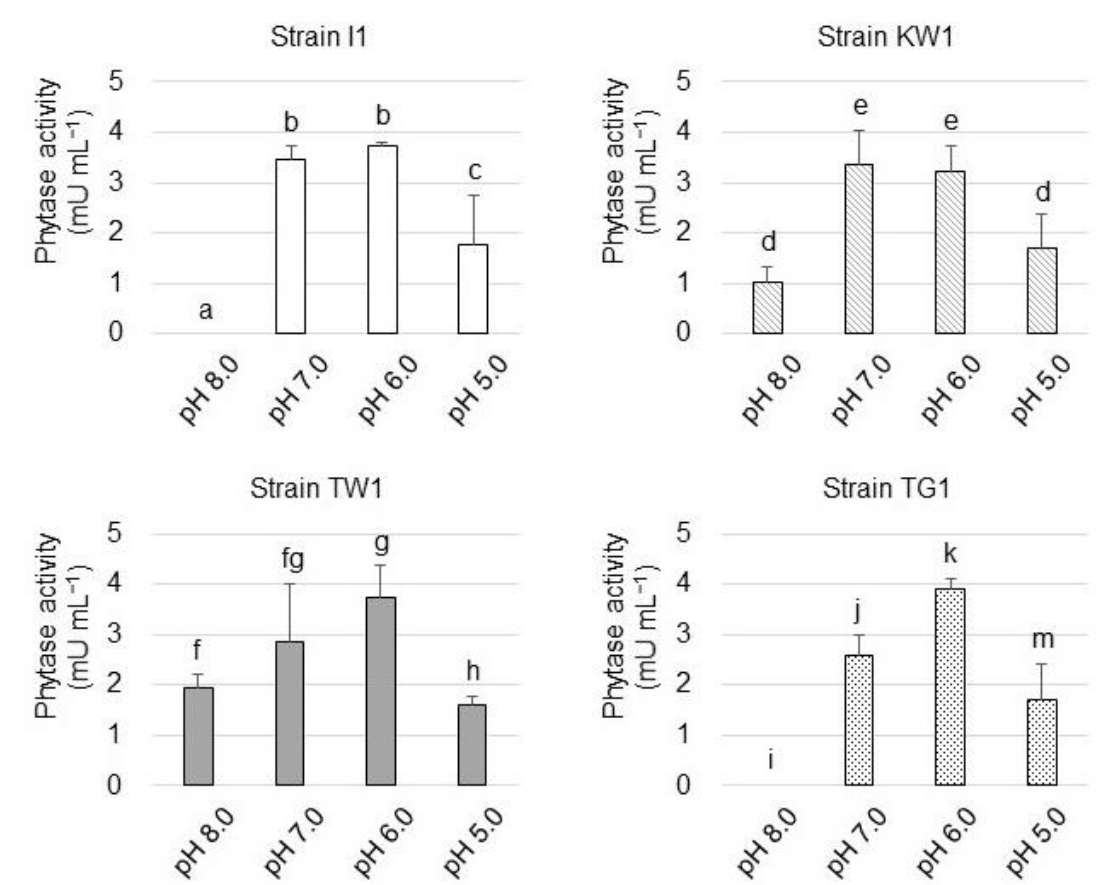
Figure 4. Phytase activity of the isolated strains at different pH values. The data are presented as means ± standard deviation of independent triplicates. Columns with different letters (a–k and m) indicate significant difference at p < 0.05 (Student’s t -test).